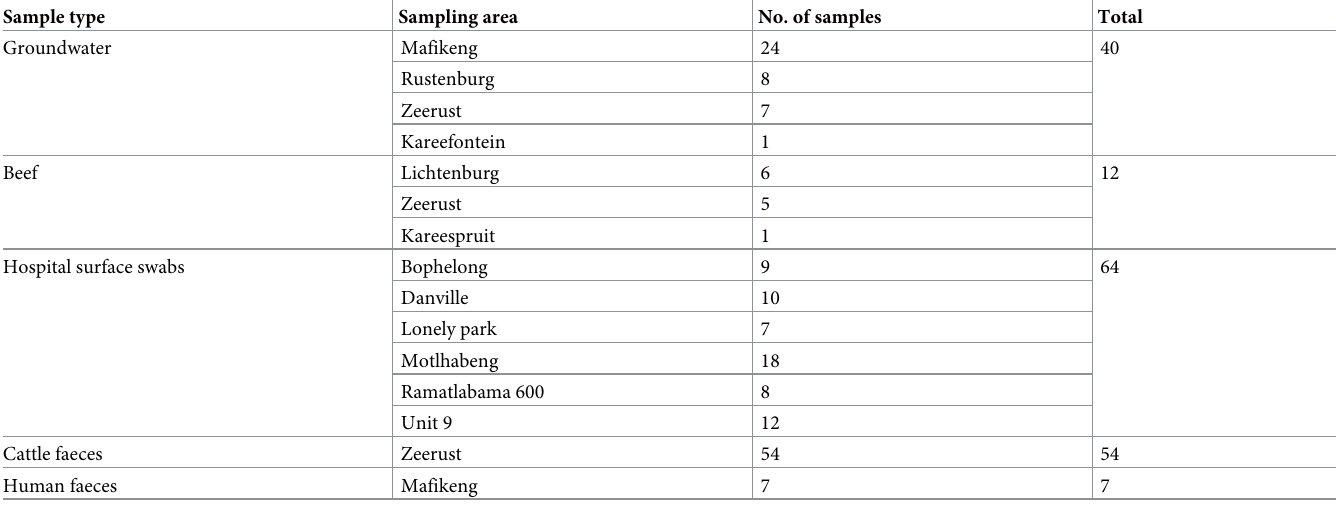
Table 1. Types and numbers of the samples collected during the study. Sample